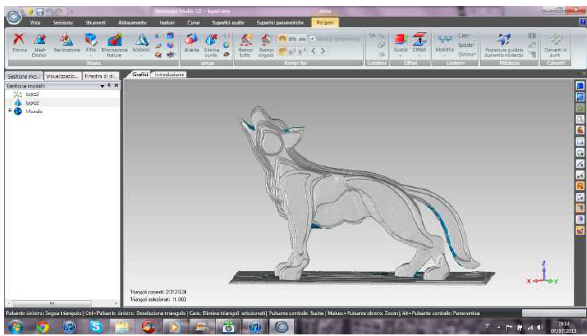
Figure 17. The model of the Wolf of Sila (from three C10 scans)